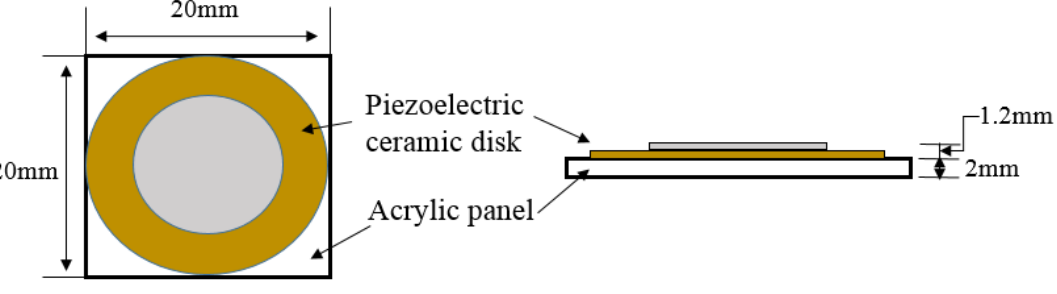
Figure 12. Haptic actuator designed for tactile feedback.